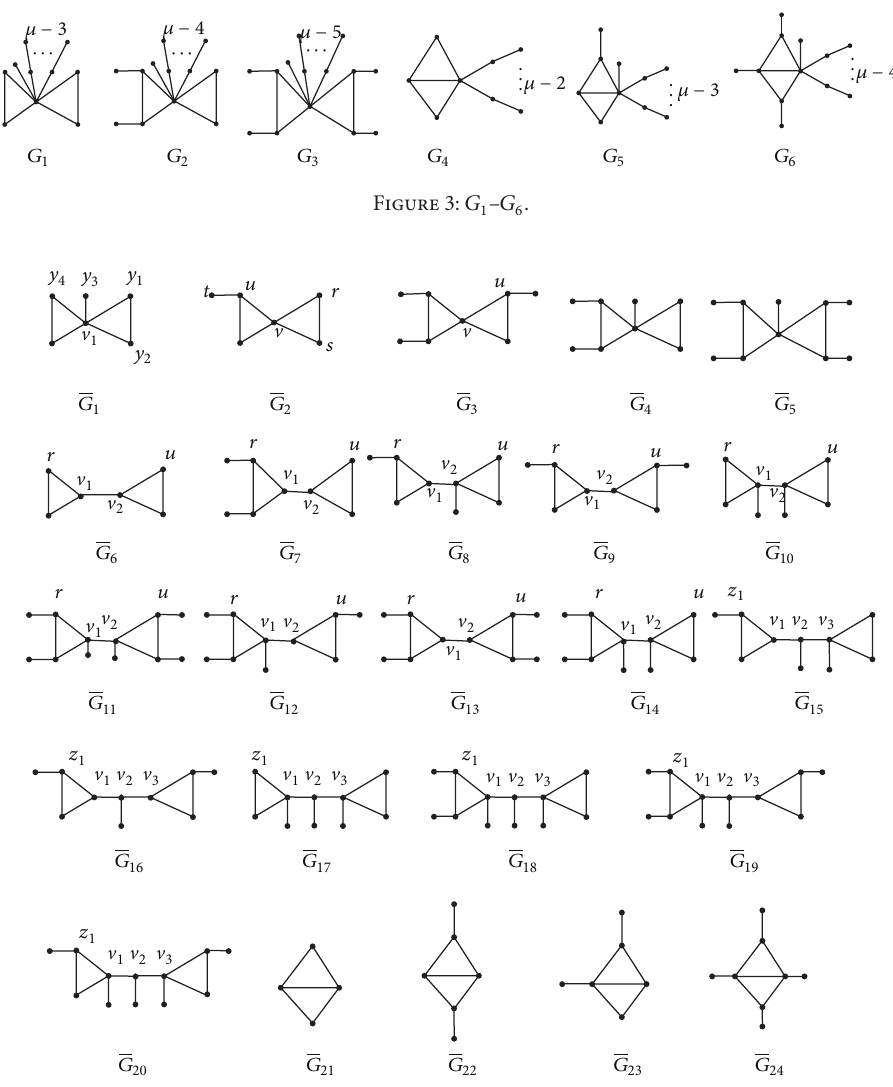
Figure 4: 𝐺 1 – 𝐺 24